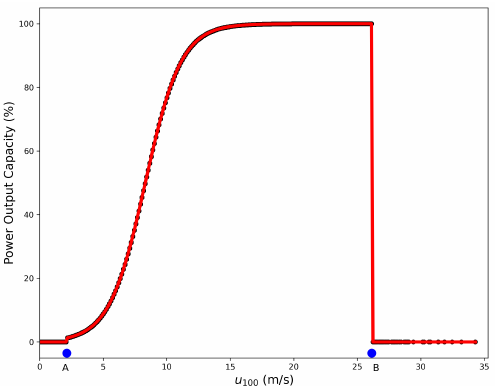
Figure 11. Wind power curve at the target area based on wind data from nearby wind farm. A and B are cut-in wind speed and cut-off wind speed, respectively.